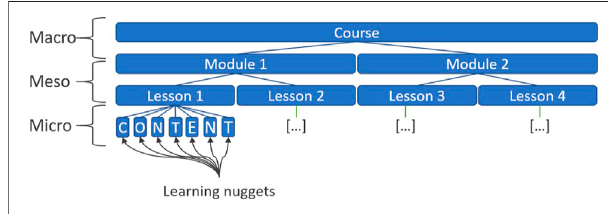
FIGURE 1 | The concatenation of elementary micro-nuggets can build higher-level educational structures such as lessons, modules, and courses.